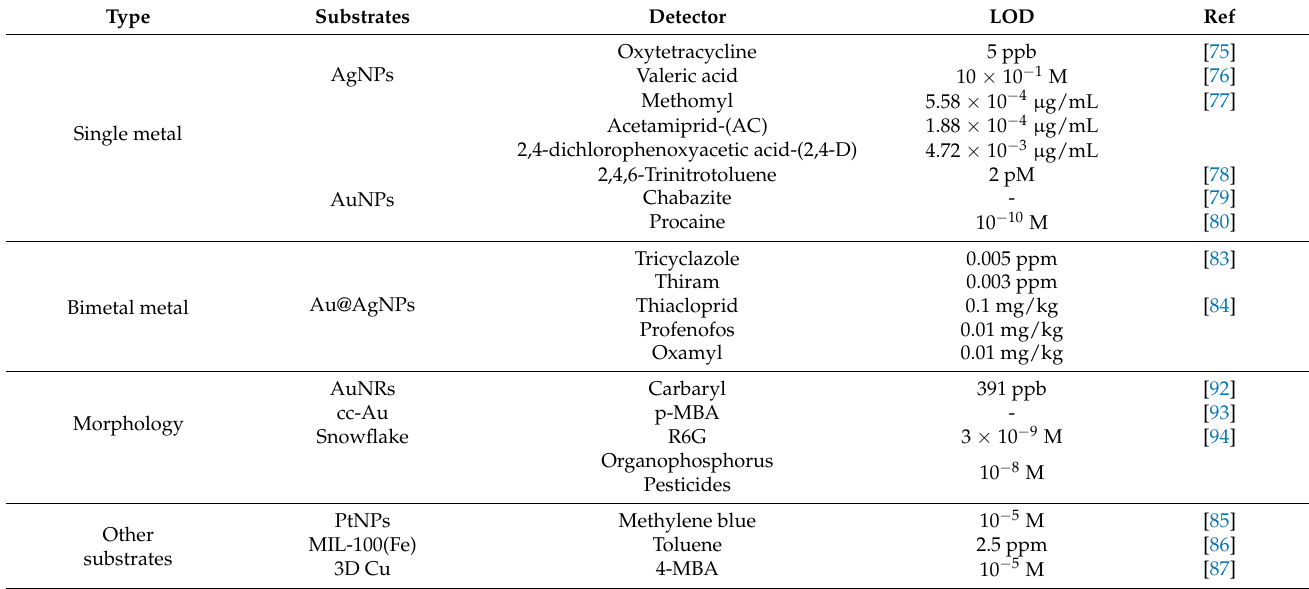
Table 1. SERS detection information of different types of